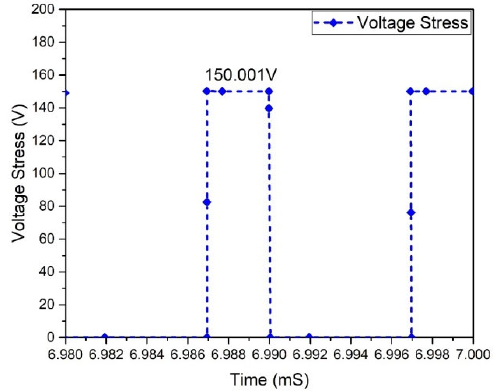
Figure 29. Voltage stress of HEMT.